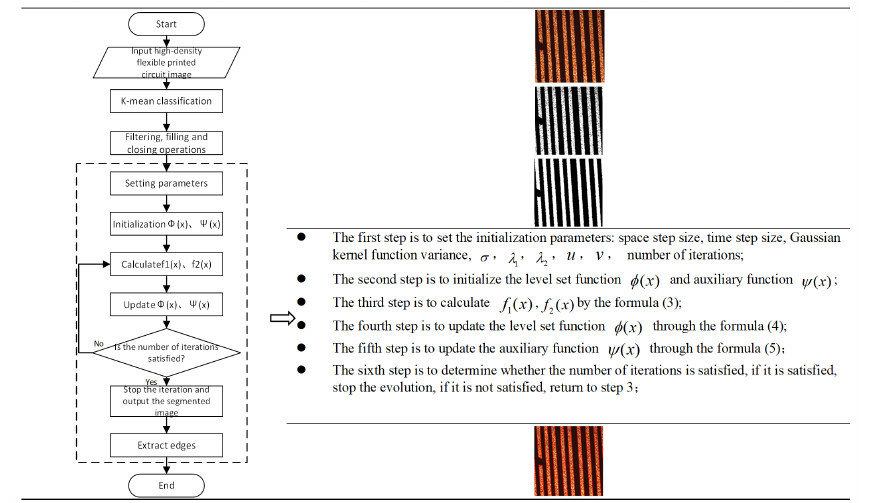
Figure 6. Schematic diagram of the main interface of the